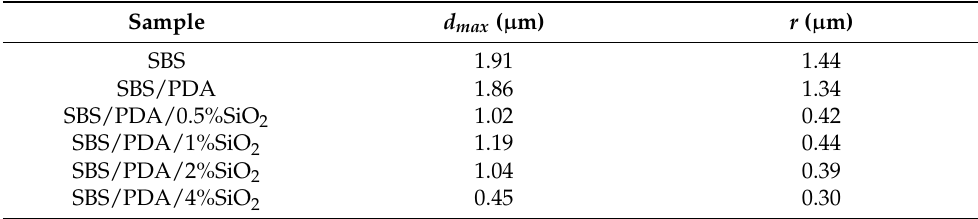
Figure 3. Figure 3. Pore size distribution of the SBS/PDA/SiO 2 fibrous membranes with different SiO 2 NPs SiO 2 NPs concentrations. concentrations. Table 1. Pore sizes of the fibrous Table 1. Pore sizes of the fibrous membrane.